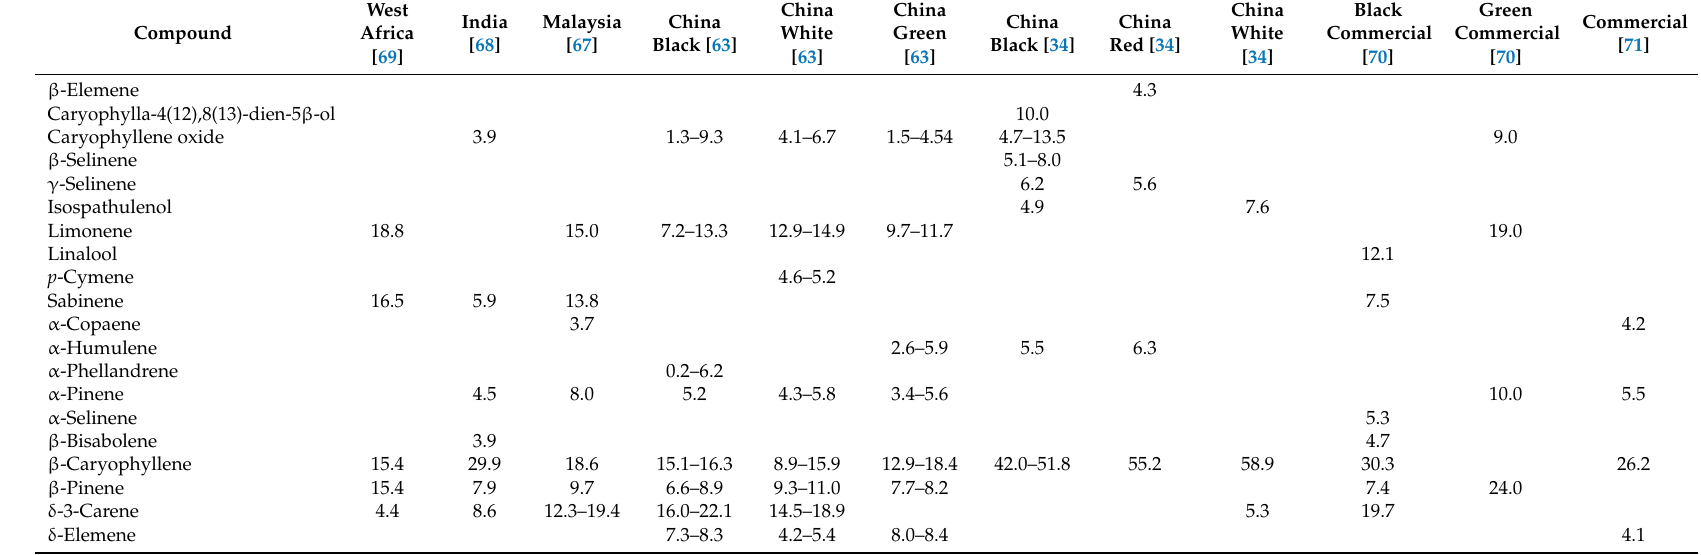
Table 12. Chemical compositions (%) of Piper nigrum L. fruit essential oils from other